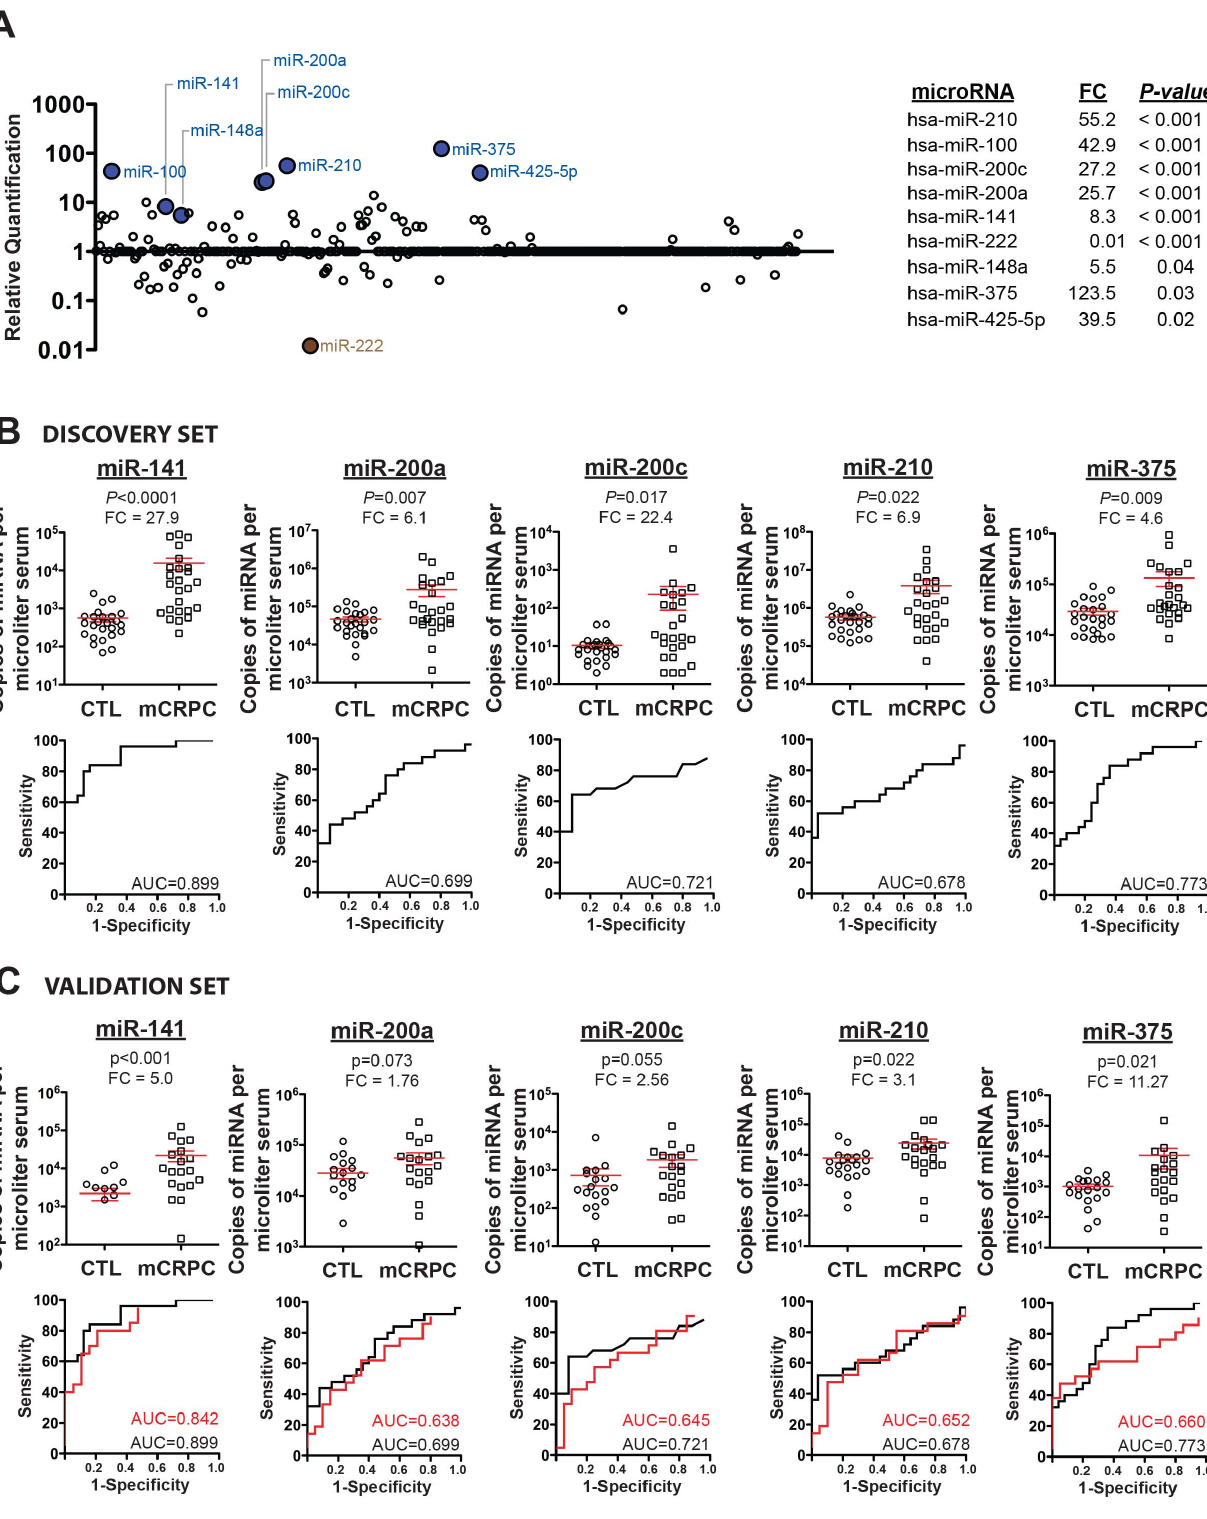
PLOS ONE | www.plosone.org 3 July 2013 | Volume 8 | Issue 7 |